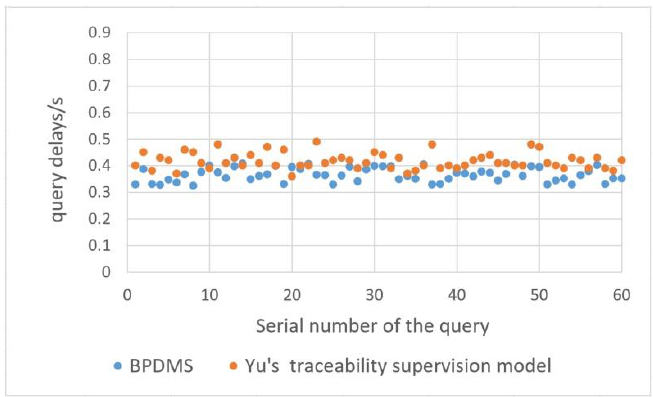
Figure 13. The comparison of accounting performance.